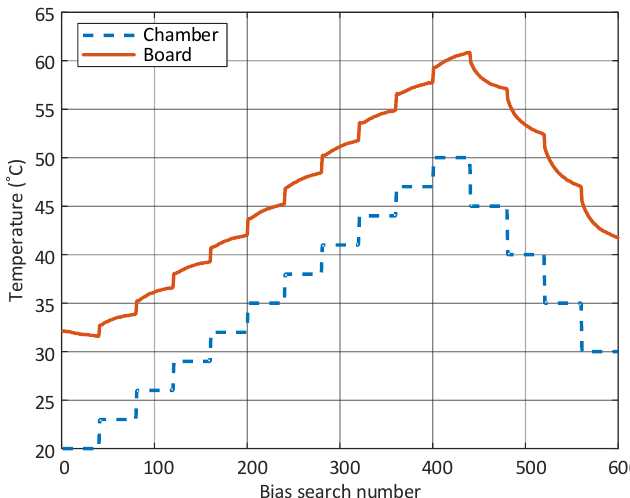
Figure 3. Temperature variations of the board according to the temperature changes inside the cham-